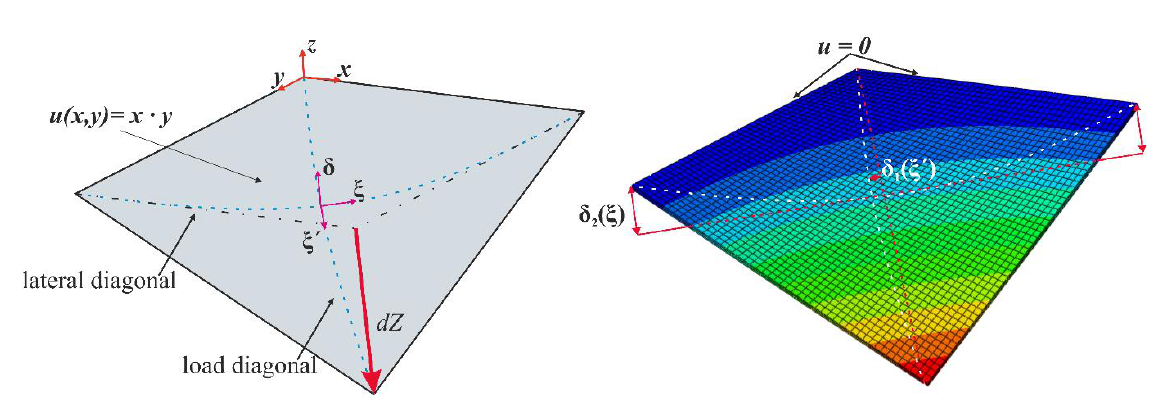
Fig. 1 Schematic overview of deformation mode and geometric